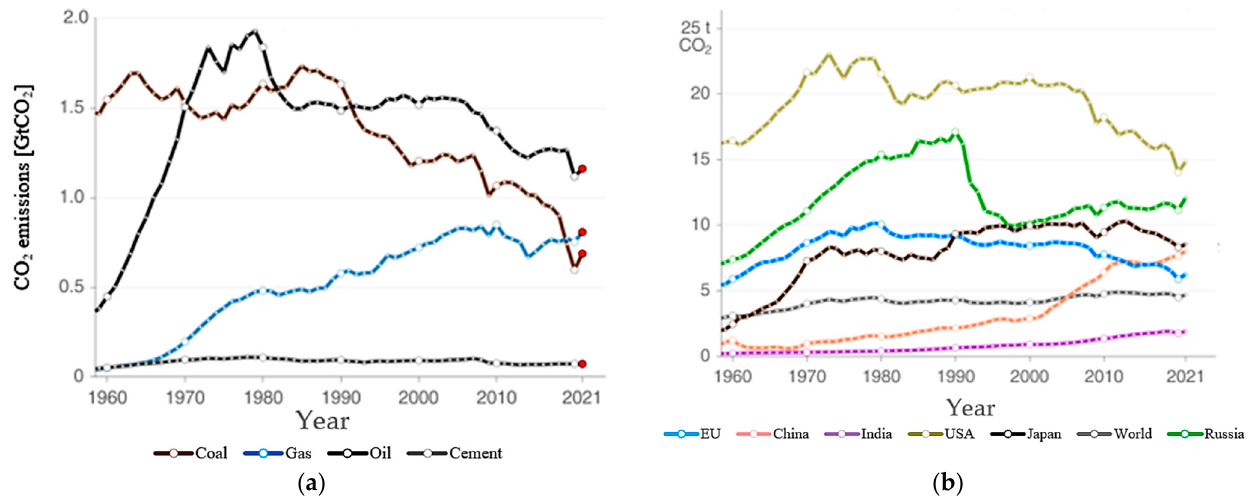
Figure 4. Emissions of CO 2 from cement and fossil fuels from 1960 to 2021 ( a ) in the EU, ( b ) per capita CO 2 by countries [20].